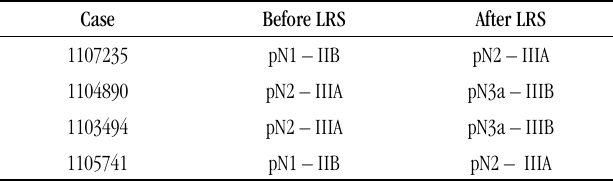
tABLE 3 − Change in pN and staging classification Case Before